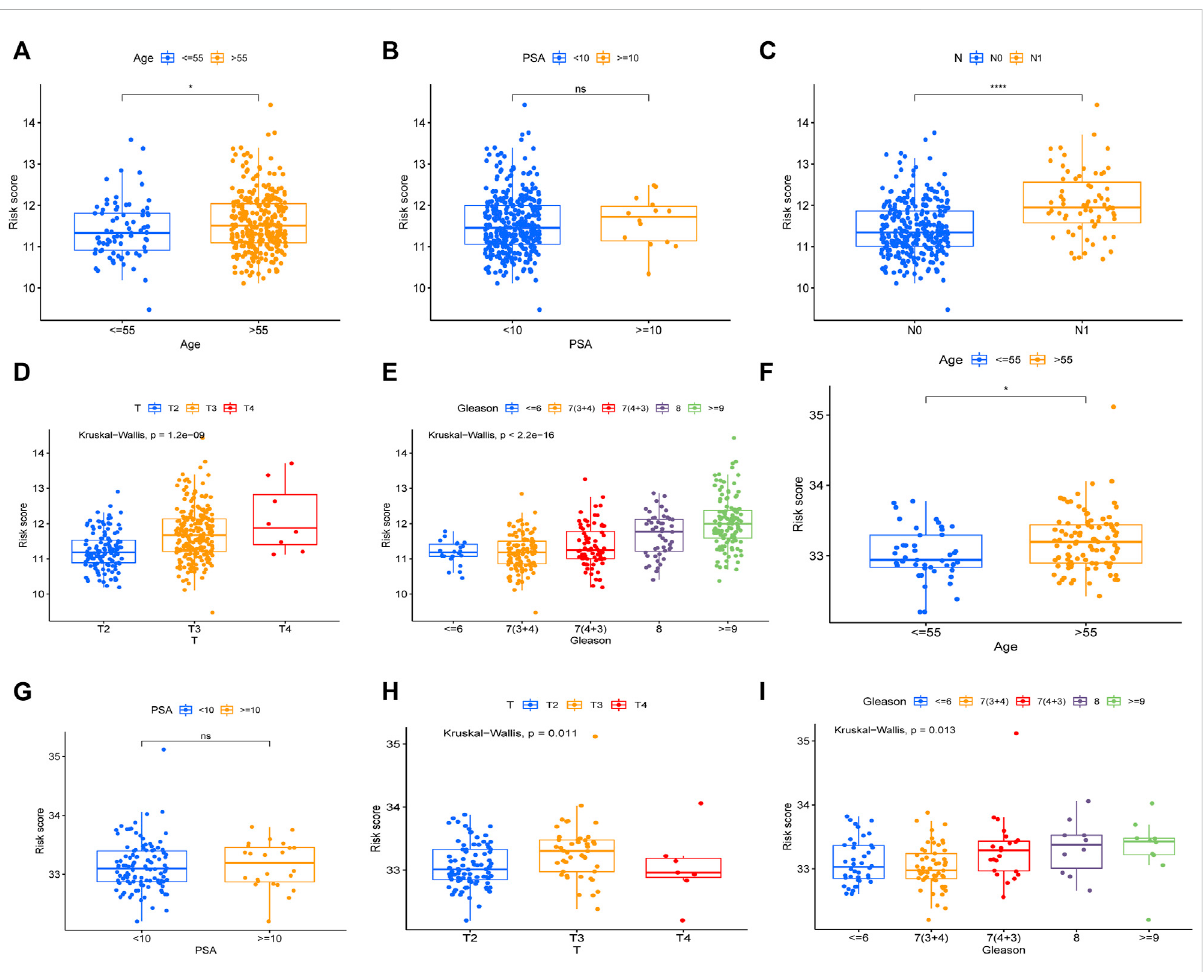
FIGURE 8 TherelationshipbetweenriskscoreandclinicalfeaturesofPCa.TherelationshipbetweenAge (A) ,PSA (B) ,N (C) ,T (D) ,Gleason (E) andriskcore in TCGA cohort. The relationship between Age (F) , PSA (G) , T (H) , Gleason (I) and risk score in MSKCC